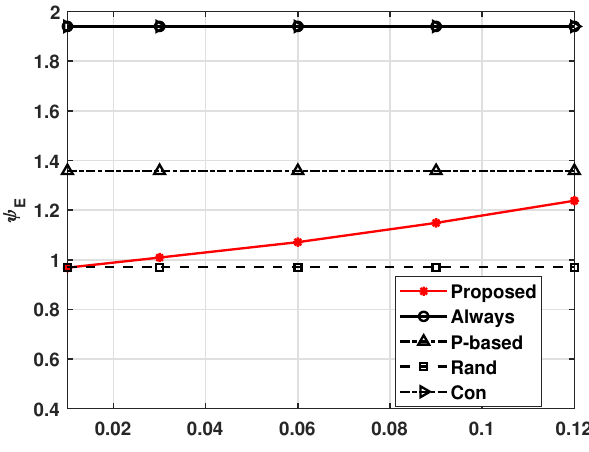
Figure 5. Successful task computational probability ψ S versus cluster lifetime ψ L with various values of (cid:101) .